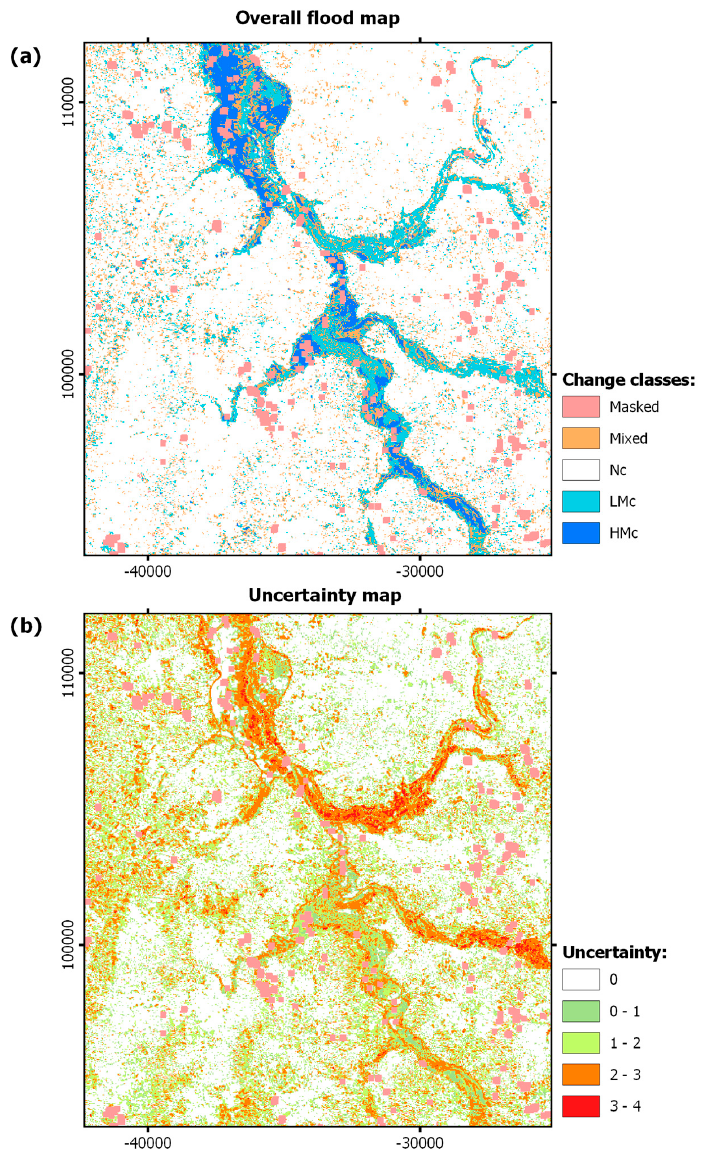
Figure 7. MINDED results for the 19 January 2003 event, at the region of interest: ( a ) Overall flood map; ( b ) Uncertainty map (Coordinate System: PT-TM06/ETRS89).